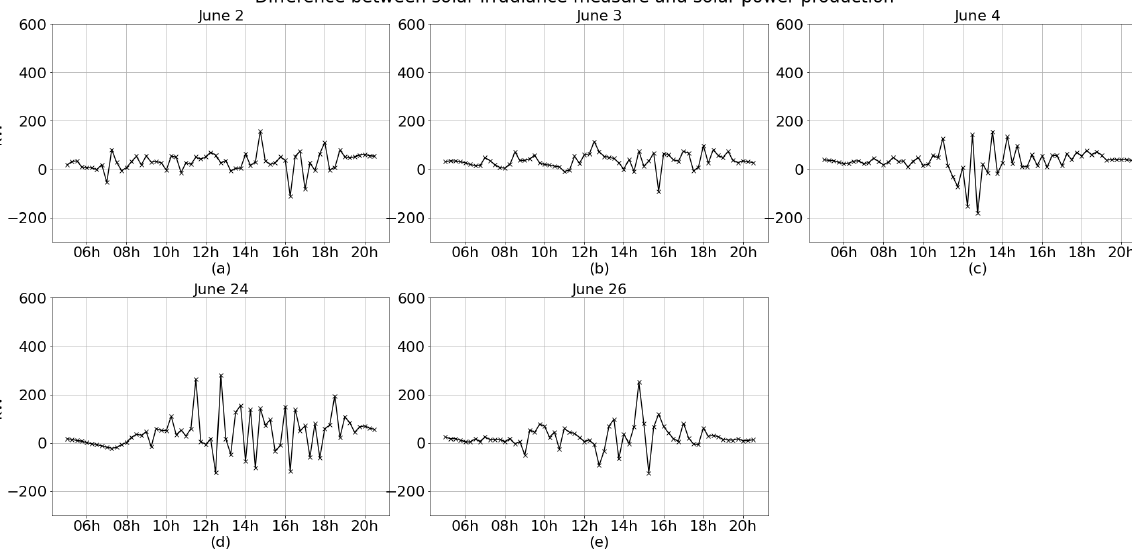
Figure 8. Difference between solar irradiance and solar power product when the solar power product is projected to the solar irradiance measure. The results are shown for the cloud types ( a ) clear sky, ( b , c ) haze clouds, ( d ) partially cloudy sky, and ( e )